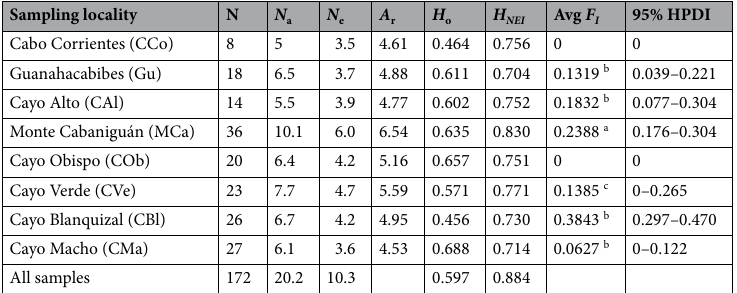
Table 1. Summary of population genetic parameters for eight Cyclura nubila nubila populations from Cuba based on seven microsatellite loci. Number of genotyped individuals ( N ), mean number of observed ( N a ) and mean number of effective alleles per locus ( N e ), rarefied allelic richness ( A r ), observed heterozygosity ( H o ), Nei’s unbiased expected heterozygosity ( H NEI ), and null allele corrected inbreeding coefficient (Avg F I ) for the a ‘fb’, b ’f’, c ‘fn’ models, with posterior 95% probability intervals (95%